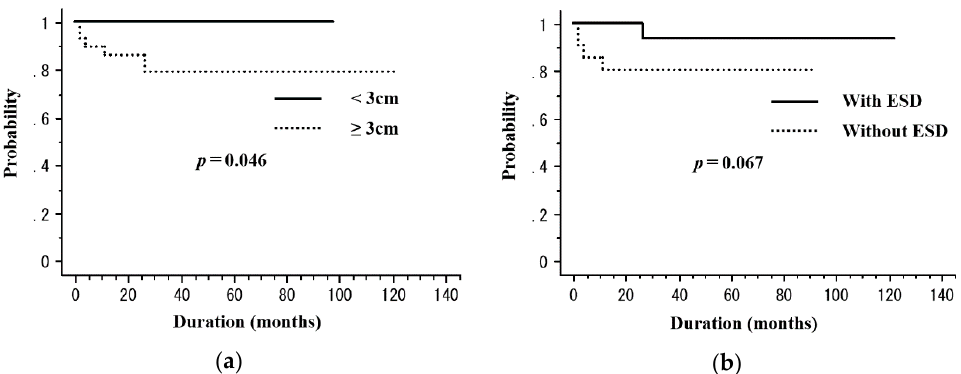
Figure 3. The local control (LC) rate according to the tumor length and the endoscopic submucosal dissection (ESD) treatment. ( a ) The LC rates are 100% in patients with tumors <3 cm and 79.3% in those with tumors ≥ 3 cm at 3 years ( p = 0.046). ( b ) The LC rates are 93.3% in patients who received ESD treatment and 80.4% in those who did not receive ESD treatment ( p = 0.067). Table 4. The univariate analysis for the disease-free survival and local control